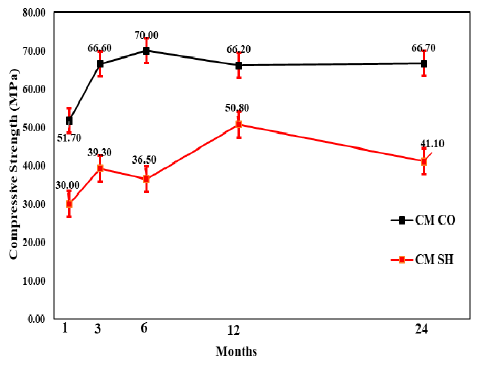
Figure 13. Cement mineral (CM) accelerator mix compressive strength by age.